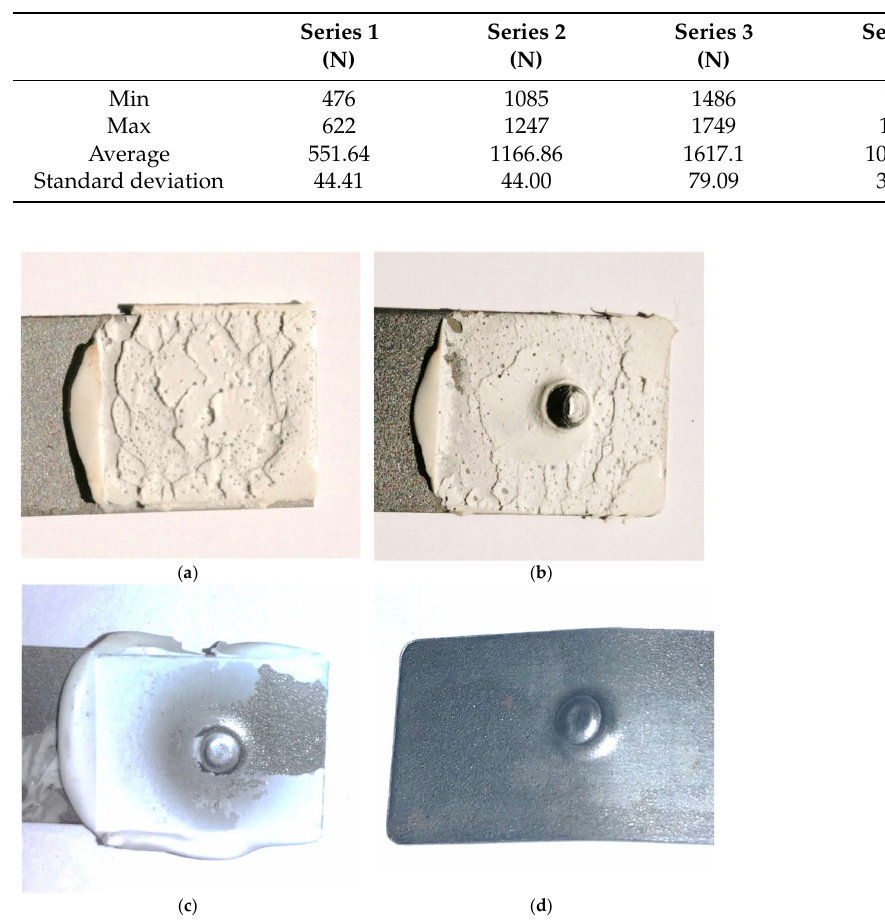
Figure 12. Example force vs. distance plots for ( a ) first test series, ( b ) second test series, ( c ) third test series, and ( d ) fourth test series. Table 8. Shear force obtained during strength tests (the complete set of results are available in the Appendix A, Table A4).